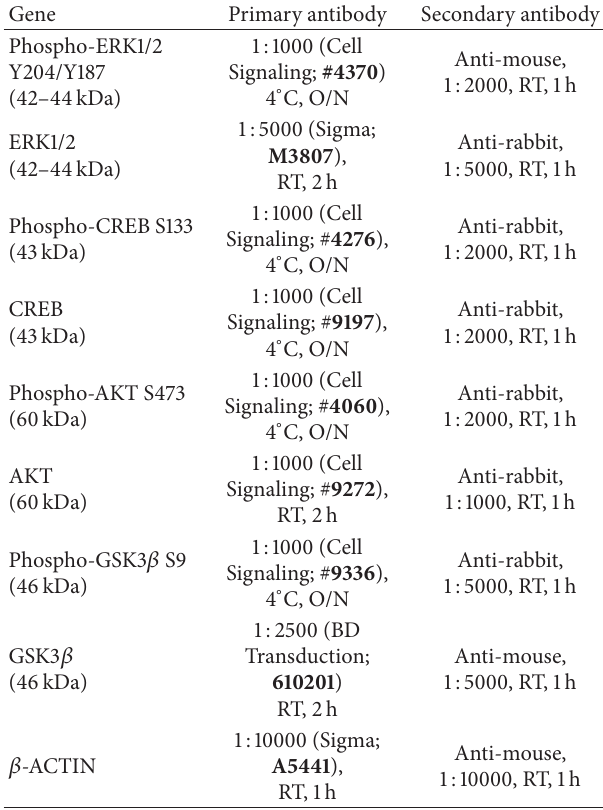
Table 1: Antibodies conditions used in the Western blot